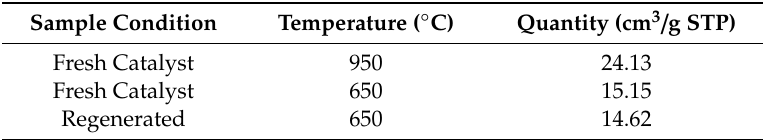
Table 4. H 2 consumption for fresh and used Fe x O y / CaO- γ -Al 2 O 3 catalysts. Influence of higher TPR temperature levels.